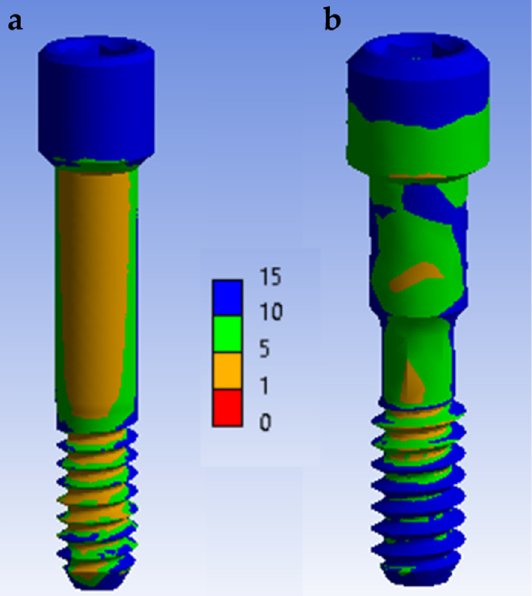
Figure 9. Safety factor map at a maximum cyclic load of 400 N after 2 × 10 6 cycles: ( a ) tube in tube connection (minimum value: 0.87) and ( b ) conical connection (minimum value: 2.2). The most critical zones are indicated in orange.